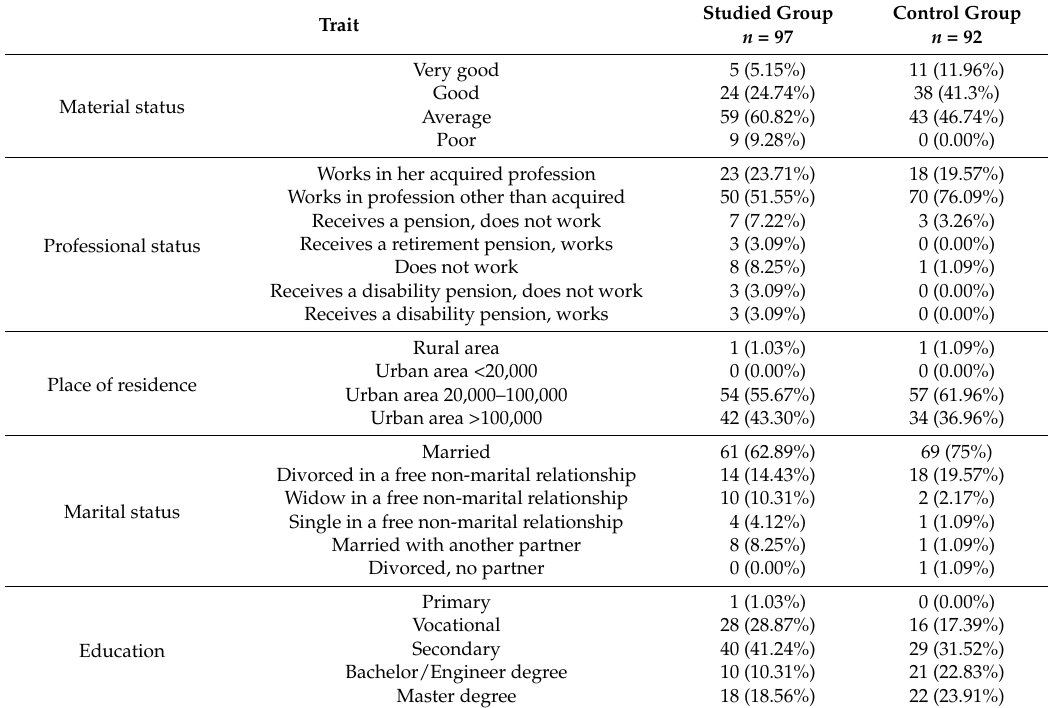
Table 1. General characteristics of the studied and control